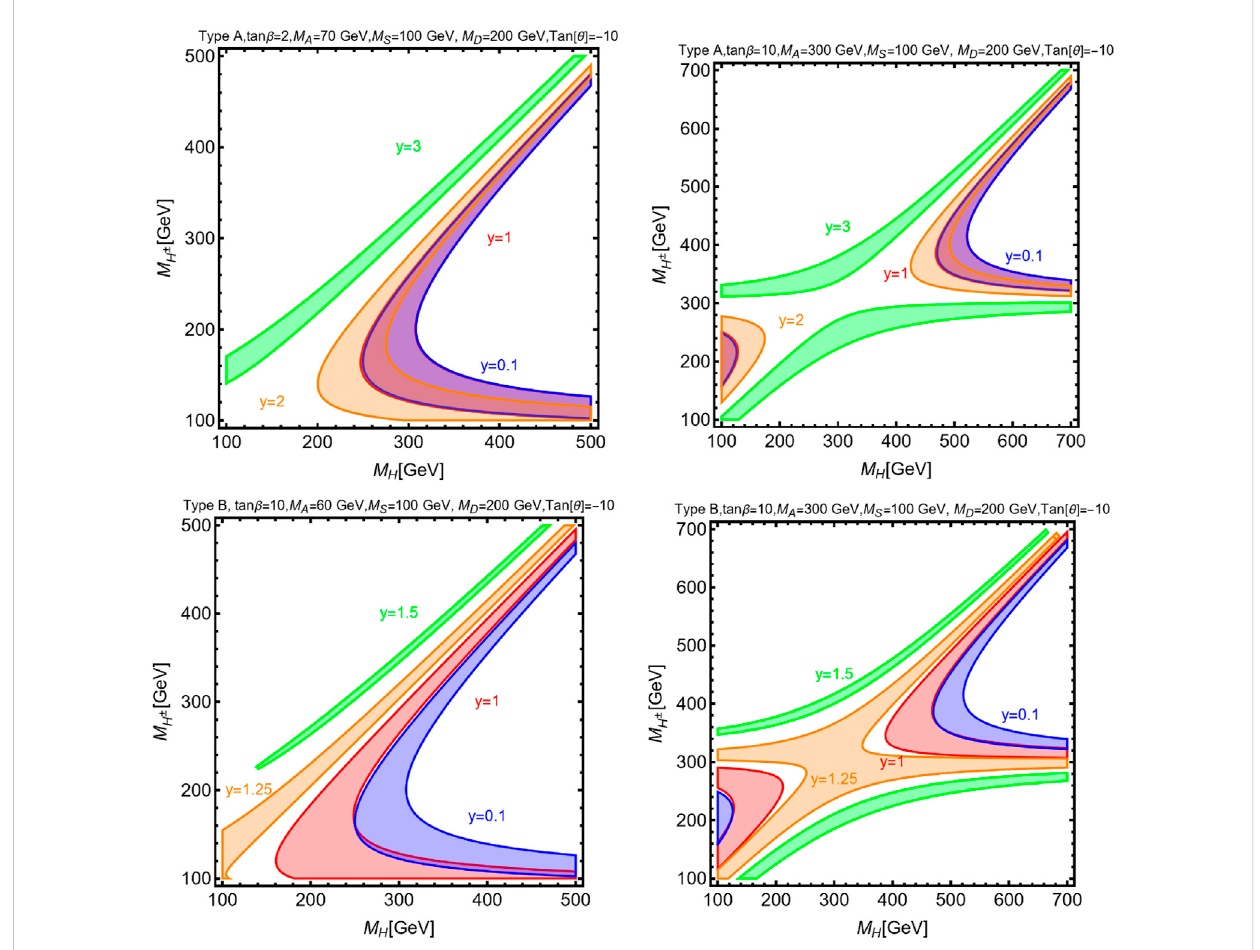
FIGURE 4 Regions in the [ M H , M H ± ] plane providing a viable fi t of the M CDF W measurement for some benchmarks of the 2HDM singlet – doublet model. The differentcolorscorrespondtothedifferentvaluesoftheYukawacoupling y reportedonthepanels.The fi rstrowreferstothetype-Acon fi gurationofthe couplings of the DM, while the second row corresponds to the type-B con fi